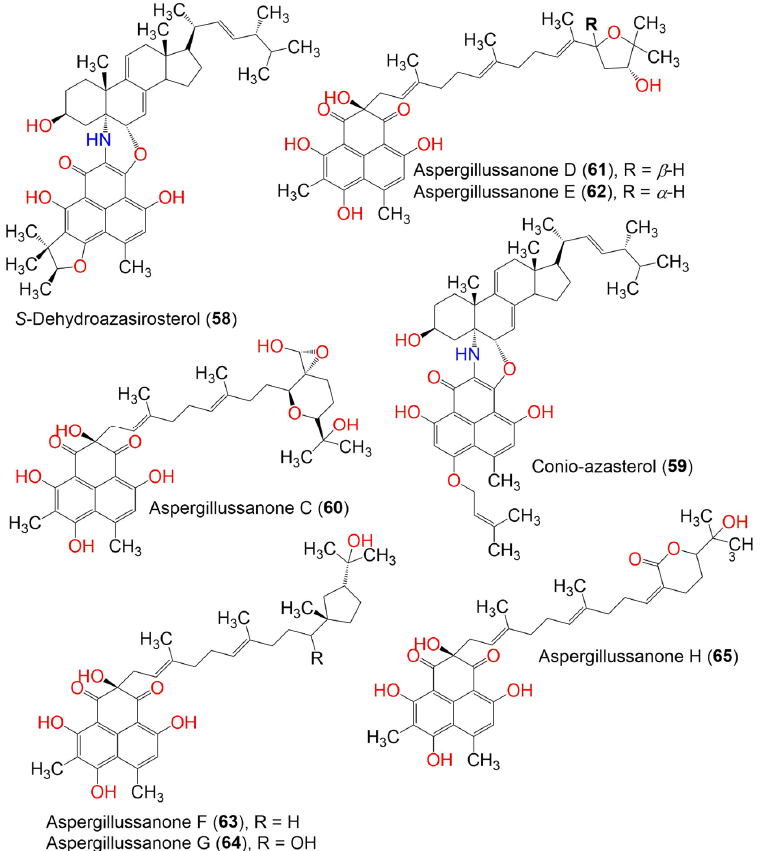
Figure 6. The structures of compounds 58–65 .